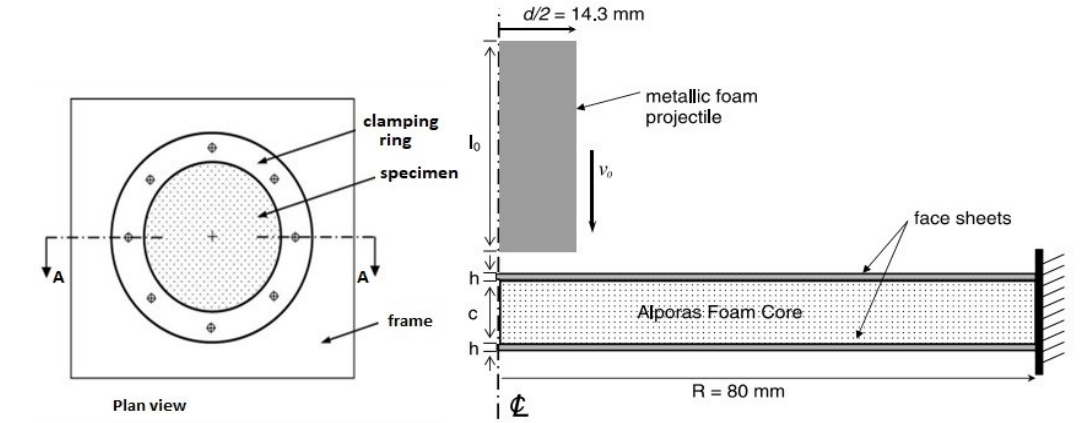
Figure 20: The problem